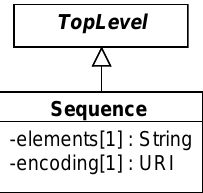
Figure 6: Diagram of the Sequence class and its associated properties.